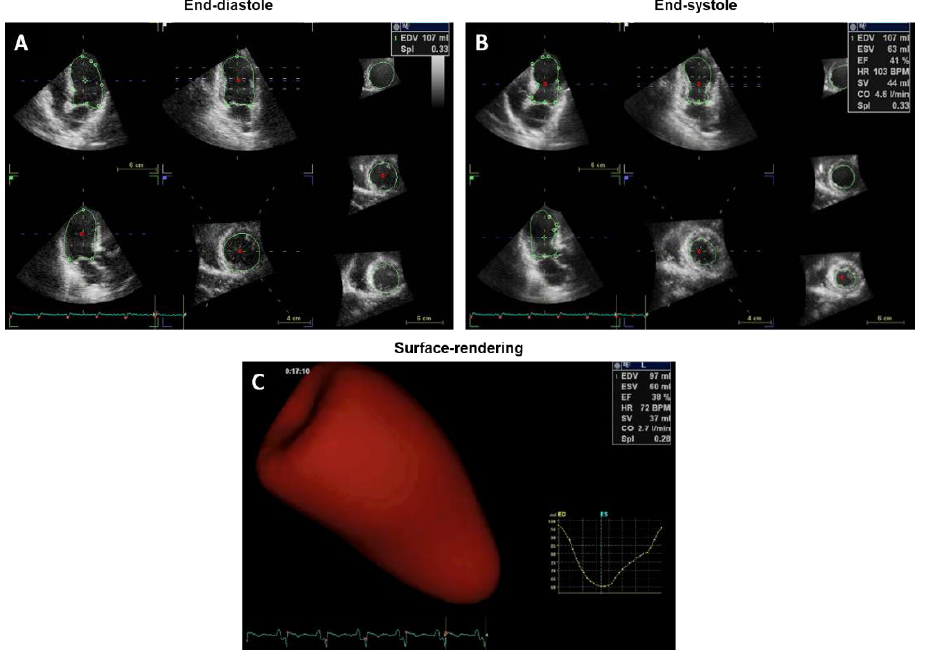
Figure 2. EF calculation by 3D transthoracic echocardiography, endocardial borders are traced in long and short-axis images and a 3D model is reconstructed Images must be acquired over several heartbeats using specific 3D imaging probes.